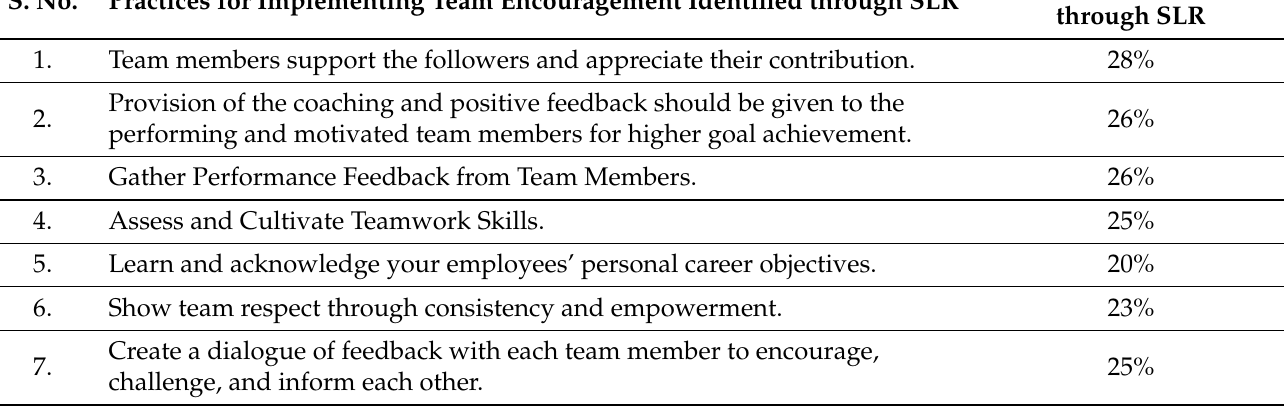
Table 9. Practices for implementing team